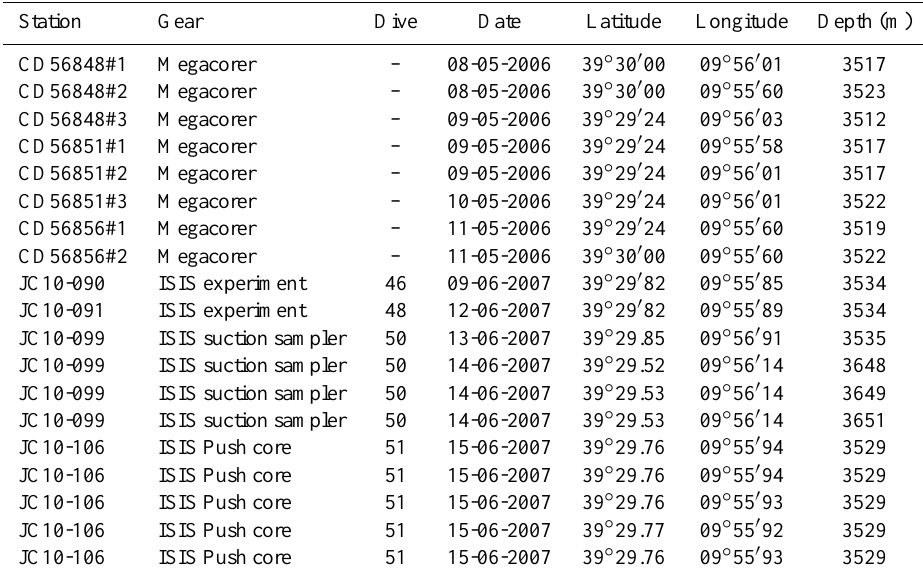
Table 1. List of the stations data outlining the samples taken during cruises carried out on board the RV Charles Darwin and RV James Cook .